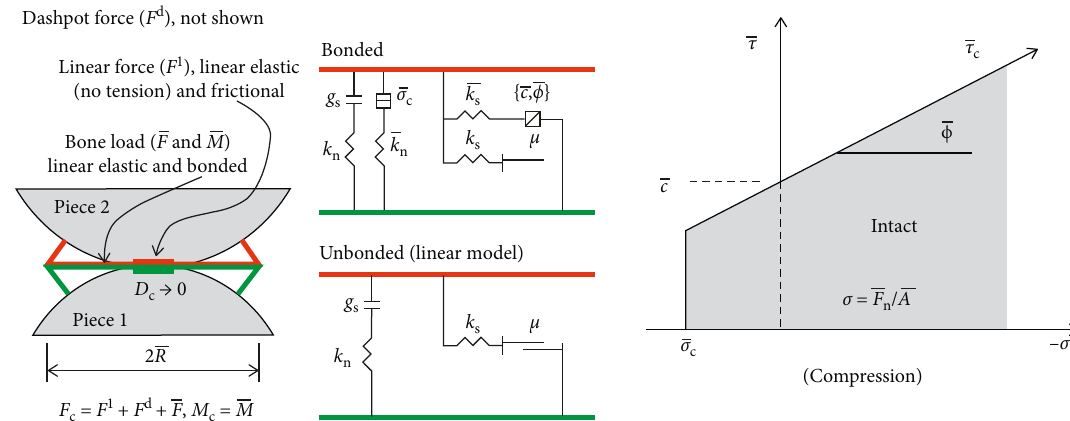
Figure 5: Mesoscopic contact model and failure criterion of the